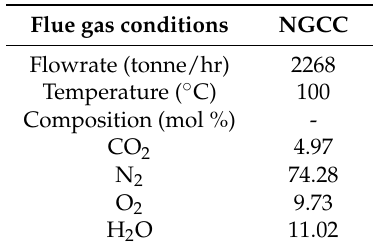
Table 1. Flue gas conditions and composition from a Natural Gas Combined Cycle (NGCC) process, which is the basis of the process